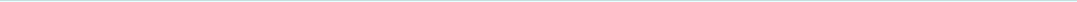
Figure 1: Holistic cancer genome profiling. Whole cancer genome profiles of four breast cancer patients. Circos plots showing the chromo- somal ideogram on the outermost ring, clockwise chr1-chr22,X,Y. Subsequent circles heading inwards: Substitutions as dots plotted on log scale of intermutation distance, small insertions/deletions, copy number (pink = losses, green = gains), rearrangements = lines (green = tan- dem duplications, pink = large deletions, blue = inversions, grey = translocations). Top right panel depicts substitution mutational signatures, next one below showing indel classes, next one below showing rearrangements. Last panel bottom right shows curated driver mutations. (A) Oestrogen receptor positive breast cancer with good outcome: a tumour with sparse mutagenesis, low numbers of substitutions, indels and re- arrangements, mainly signatures 1 and 5. 1q gain and 16q loss are common. (B) Characteristic BRCA1 null tumour with high levels of substi- tution signature 3, deletions with microhomology, multiple copy number losses and tandem duplications throughout the genome. (C) Mismatch repair deficient tumour with high numbers of signatures 6 and 26, and a very large number of indels at polynucleotide repeat tracts. (D) Mixed APOBEC-mutated and mismatch repair deficiency demonstrating that tumours can have multiple mutational